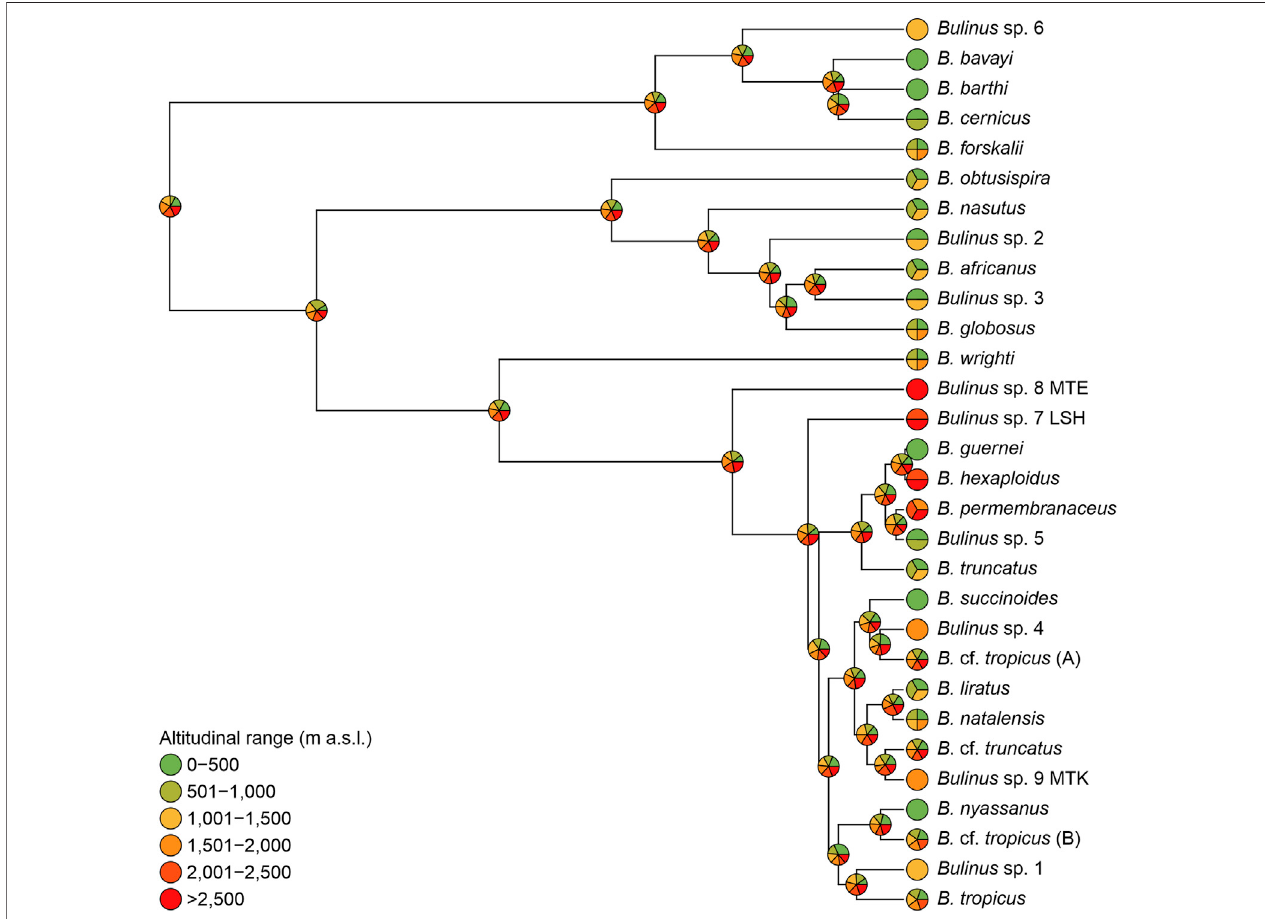
FIGURE4| CharacterevolutionofaltitudinalbandsalongtheBEASTMCCMOTU-liketree.Sixclassesofaltitudinaloccurrencesareusedandpiechartsrepresent probabilities of ancestral states at the respective nodes (see also Supplementary Tables S2, S3 ).